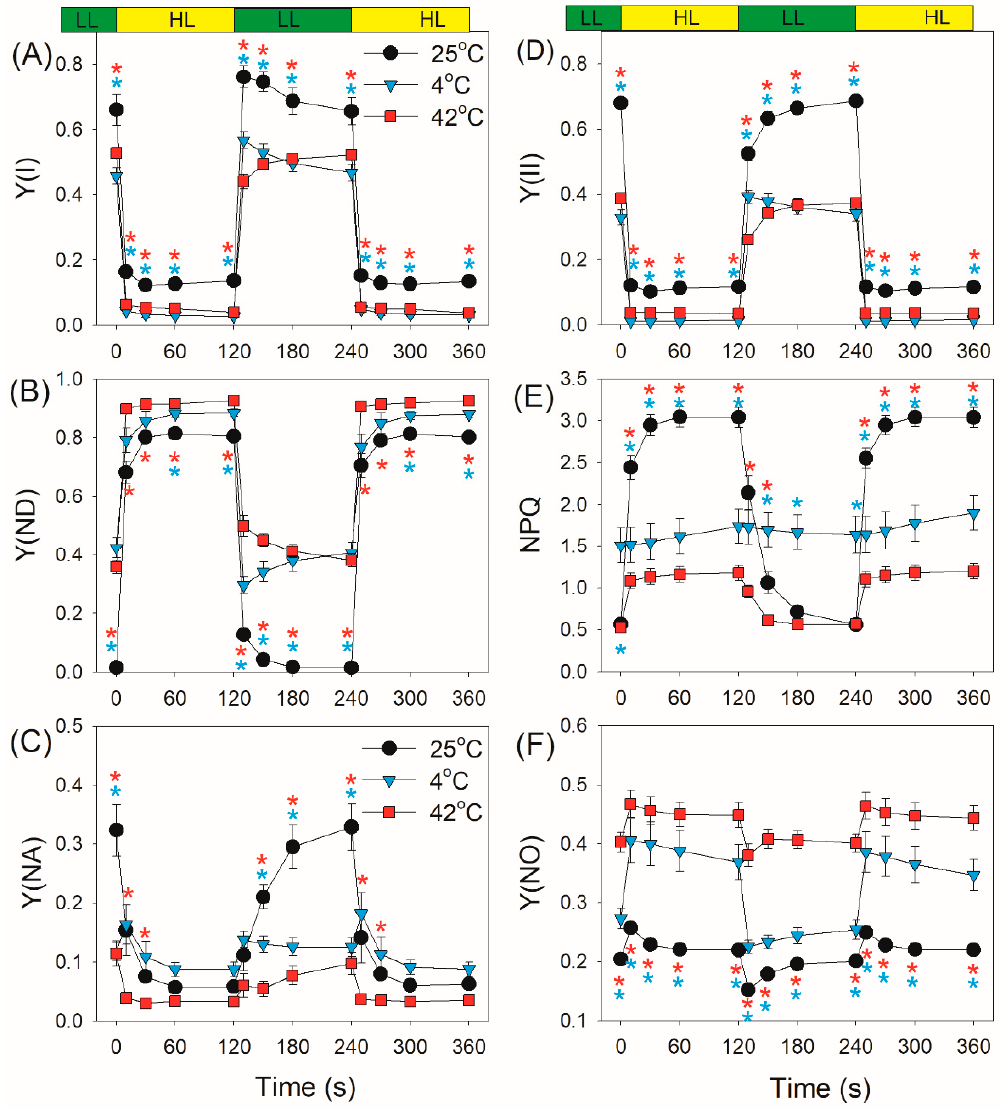
Figure 5. Changes in PSI and PSII parameters after transition from 59 to 1455 μ mol photons m − 2 s − 1 at 25 °C, 4 °C, and 42 °C. ( A – C ) Y(I), Y(ND) and Y(NA); ( D – F ) Y(II), NPQ and Y(NO). Values are means ± SE ( n = 5). Red asterisks indicate significant differences between 25 °C and 42 °C, and blue asterisks indicate significant differences between 25 °C and 4 °C.